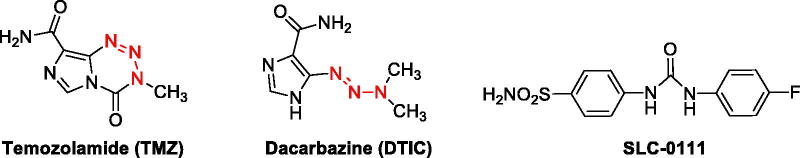
Clinically used triazene substituted compounds (TMZ and DTIC) and efficient CAI SLC-0111 (phase I/II trials for the advanced metastatic solid tumours).